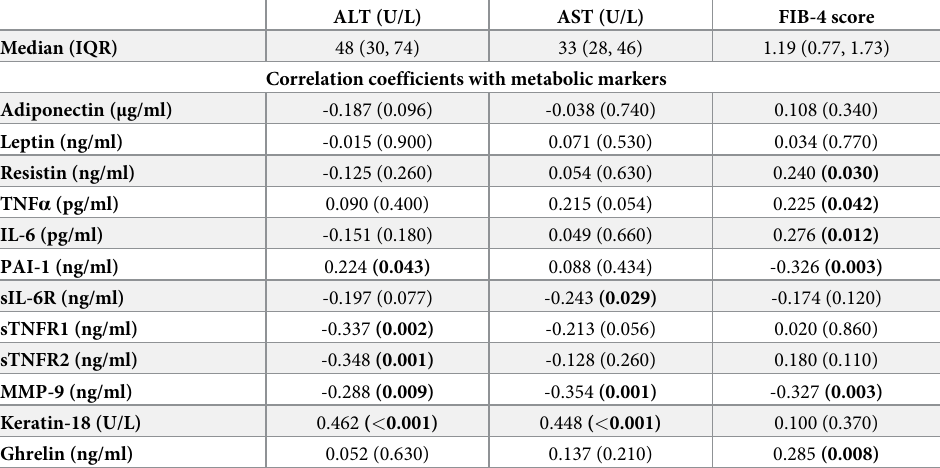
Table 2. Correlations between aspartate aminotransferase (AST), alanine aminotransferase (ALT) serum levels and FIB-4 score with various metabolic markers in 105 study patients. Spearman correlation coefficients (p-value) are presented for each marker and significant p- values are shown in BOLD